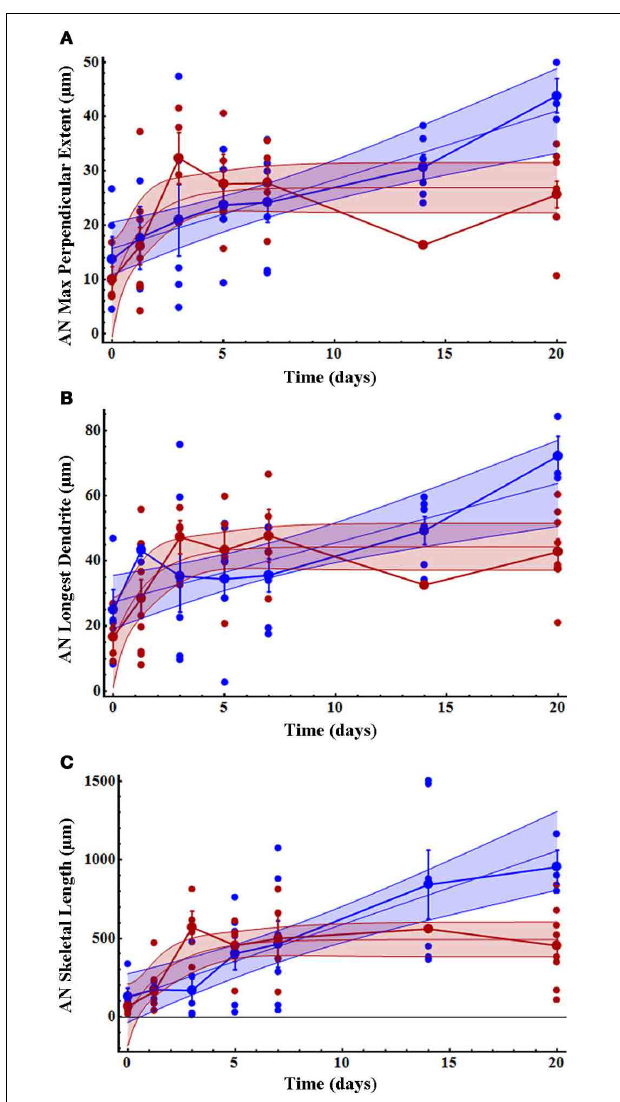
FIGURE 3 | Initial AN growth across the midline increased more rapidly in females than males over time after deafferentation. (A) AN dendritic maximum perpendicular extent, (B) longest dendrite, and (C) skeletal length increased non-linearly in females (red) and linearly in males (blue). Dendritic length in females reached a plateau by 3 days after deafferentation, while male dendritic length increased more slowly and did not plateau within the measured time period. The mean for each time point is shown as a slightly larger data point, and error bars represent standard error of the mean. The blue and red shaded areas represent 95% confidence intervals. Female AN control ( n = 4), 30h ( n = 9), 3 days ( n = 4), 5 days ( n = 4), 7 days ( n = 7), 14 days ( n = 1), and 20 days ( n = 9). Male AN control ( n = 5), 30h ( n = 4), 3 days ( n = 6), 5 days ( n = 8), 7 days ( n = 7), 14 days ( n = 6), and 20 days ( n = 3). See Table 1 for regression equations and